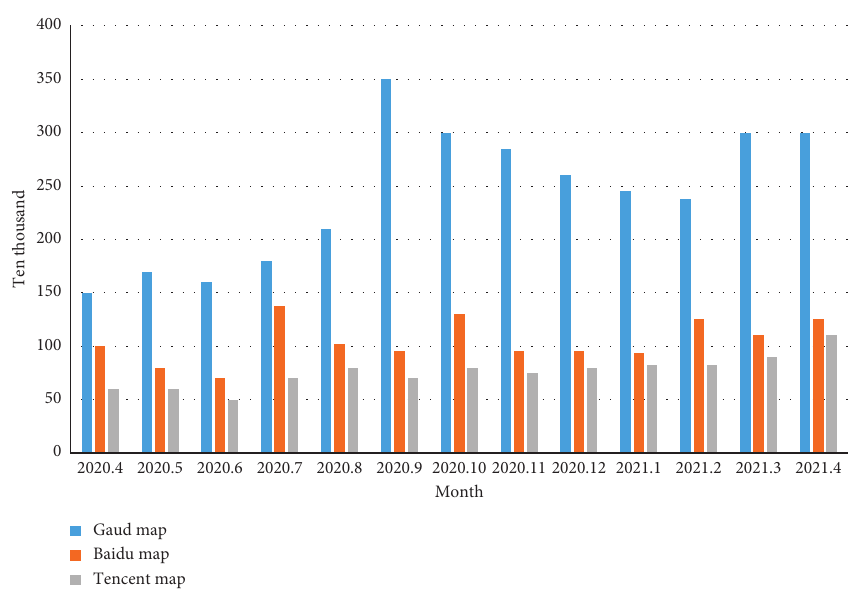
Figure 11: Travel platform distribution information of itinerary navigation.